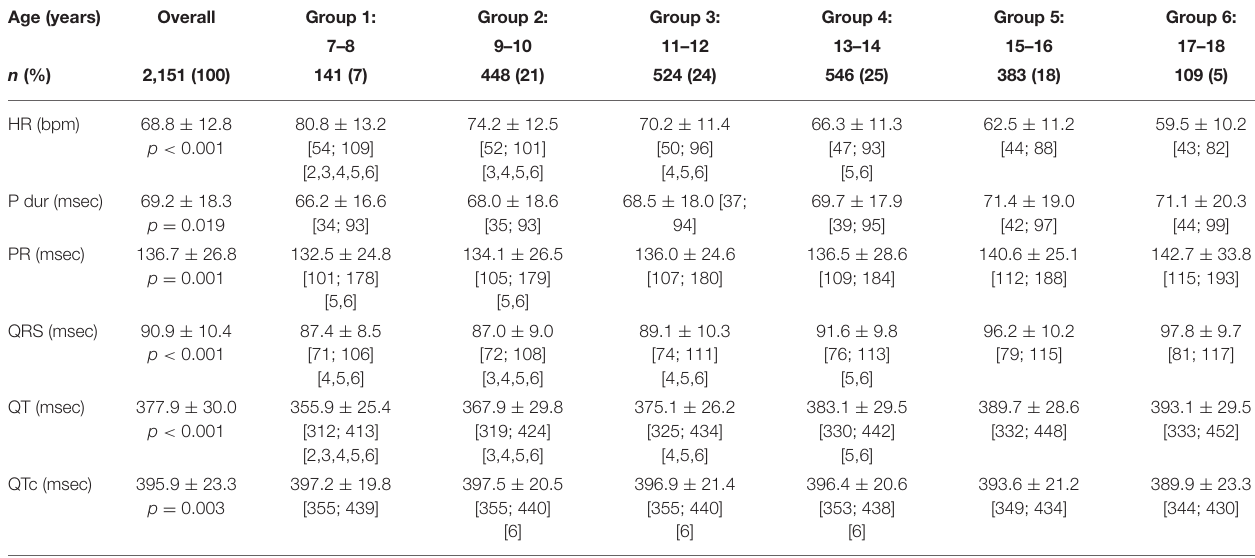
TABLE 2 | Electrocardiographic measurements per age groups.